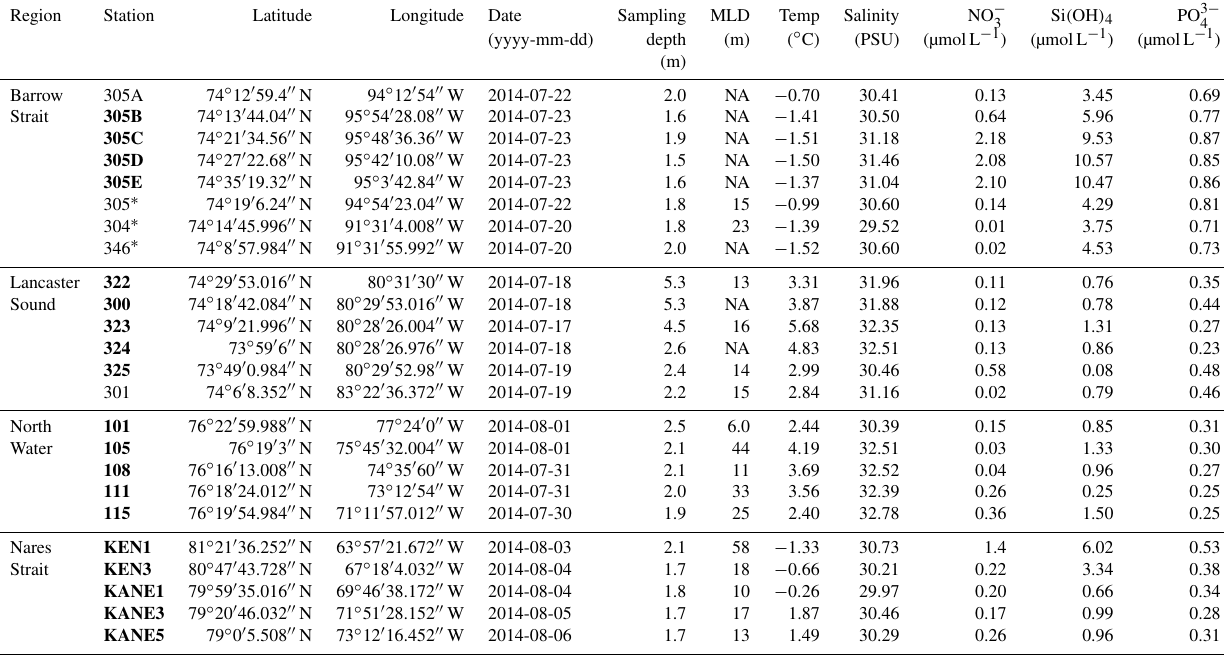
Table 1. Physicochemical characteristics of the surface waters sampled during the ArcticNet–NETCARE campaign during July–August 2014 grouped within different regions of the Arctic. The surface mixed-layer depth is denoted as MLD. Nitrate (NO − phosphate (PO 3 − ) are also shown. Ice-covered stations are marked with an asterisk. Stations in bold are included in the vertical cross section 4 transect figures (Figs. 4 to 7). Values that were not available are noted as